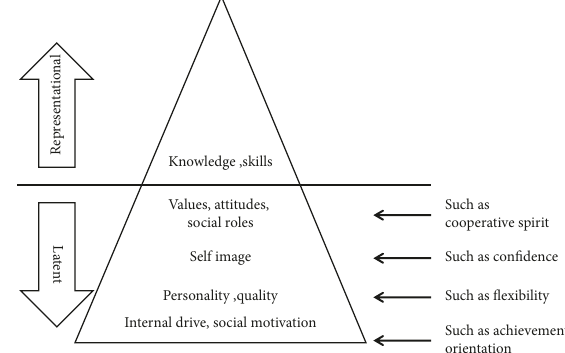
Figure 2: Iceberg model of